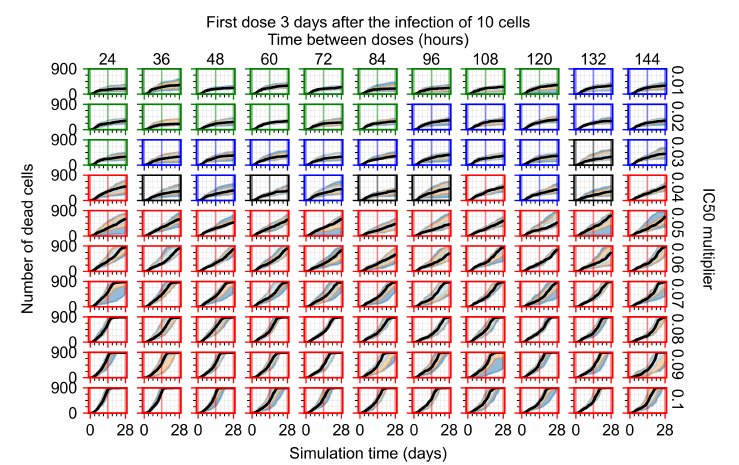
Figure A102. Infected (secreting extracellular virus) population.